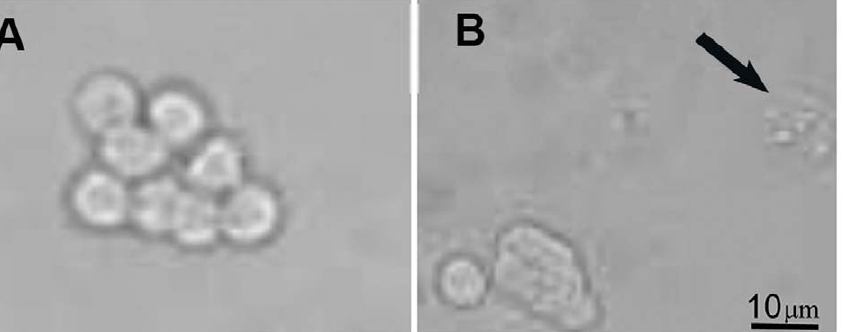
Figure 3. Effect of AChE C-terminus peptides of 30 amino acids (T30) on morphology of PC12 cells. (A) Control cells presented a round shape with a big nucleus. In contrast, (B) Cells treated with T30 presented granulation of the nucleus () as apoptotic